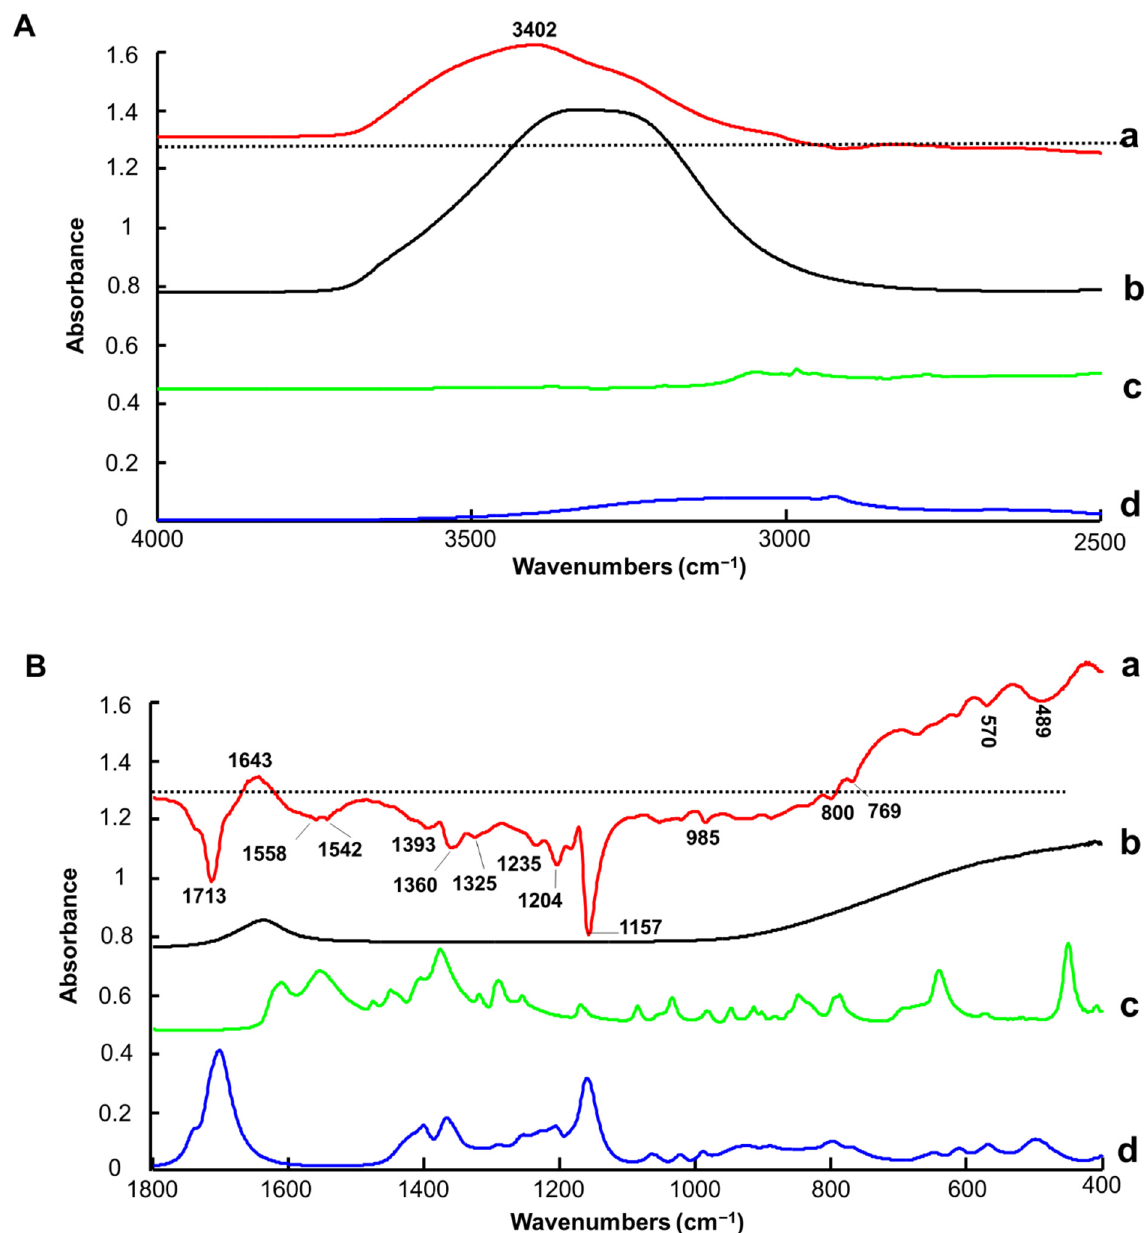
Figure 3. First regression coefficient from PLSR of ATR-IR (dotted line indicates the zero baseline) (a), water spectrum (b), L-Proline (c) and Levulinic Acid (d) in the spectral range 4000–2500 cm − 1 ( A ) and the spectral range 1800–400 cm − 1 ( B ). Spectra are offset for clarity.